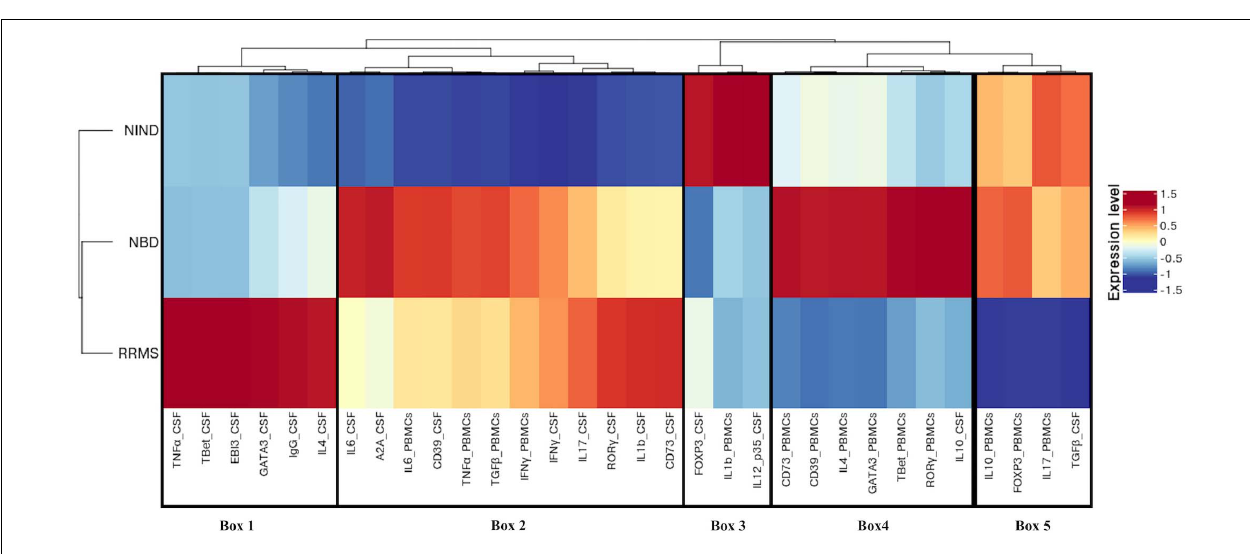
FIGURE 4 | Different expression patterns of CSF and blood immune genes in NBD, RRMS, and NIND diseases. Feature expression heatmap was generated using the scaled and centered mean expression level of CSF and blood variables. Genes and disease groups were ordered based on hierarchical clustering. Boxes indicate the major distinct expression pattern and are detailed in the main